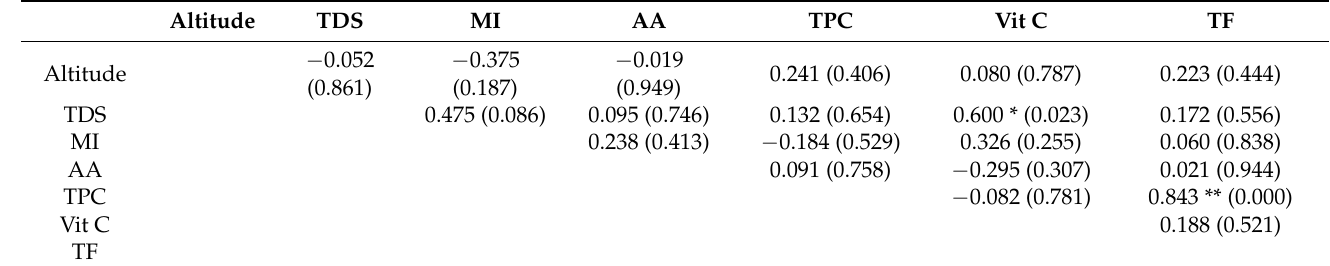
Table 2. Pearson’s correlation coefficients for the Greek C. mas genotypes ( n = 14) between altitudes (m), four fruit nutraceutical properties assessed namely total phenolic content (TPC, mgGAE/100 g), antioxidant activity (AA, %RSA), total flavonoids (TF, mgCE/100 g), and vitamin C content (Vit C, mgAAE/100 g) as well as two complementary fruit phytochemical properties measured, i.e., maturity index (MI) expressed as the ratio of sugar content ( ◦ Brix) to malic acid content (gMA/100 g) and total dissolved solids (TDS, mg/L).